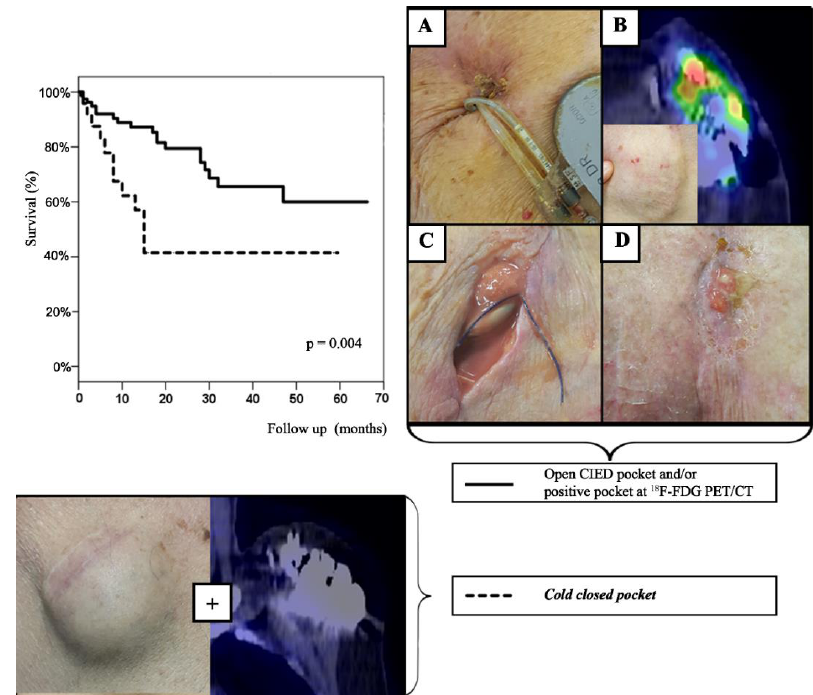
Figure 4. Survival curves (Kaplan–Meier) considering all-cause mortality according to the pres- ence/absence of a “cold closed pocket”, defined as the absence of pocket skin lesion or metabolic activity revealed by 18F-FDG PET/CT scan. Legend: A , C , D = cases of CIED infection with overt pocket involvement. B = CIED infection with hidden pocket involvement, as revealed by 18F-FDG PET/CT. Reproduced from “Contribution of PET imaging to mortality risk stratification in candi- dates to lead extraction for pacemaker or defibrillator infection: a prospective single center study” Diemberger, I. et al., 2019, European Journal of Nuclear Medicine and Molecular Imaging, 46, 194–205, Copyright [2019] by the Springer